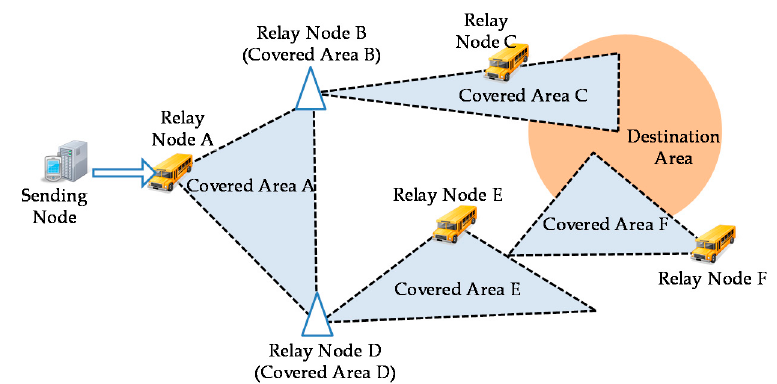
Figure 6. Layout example of the destination area and covered areas.